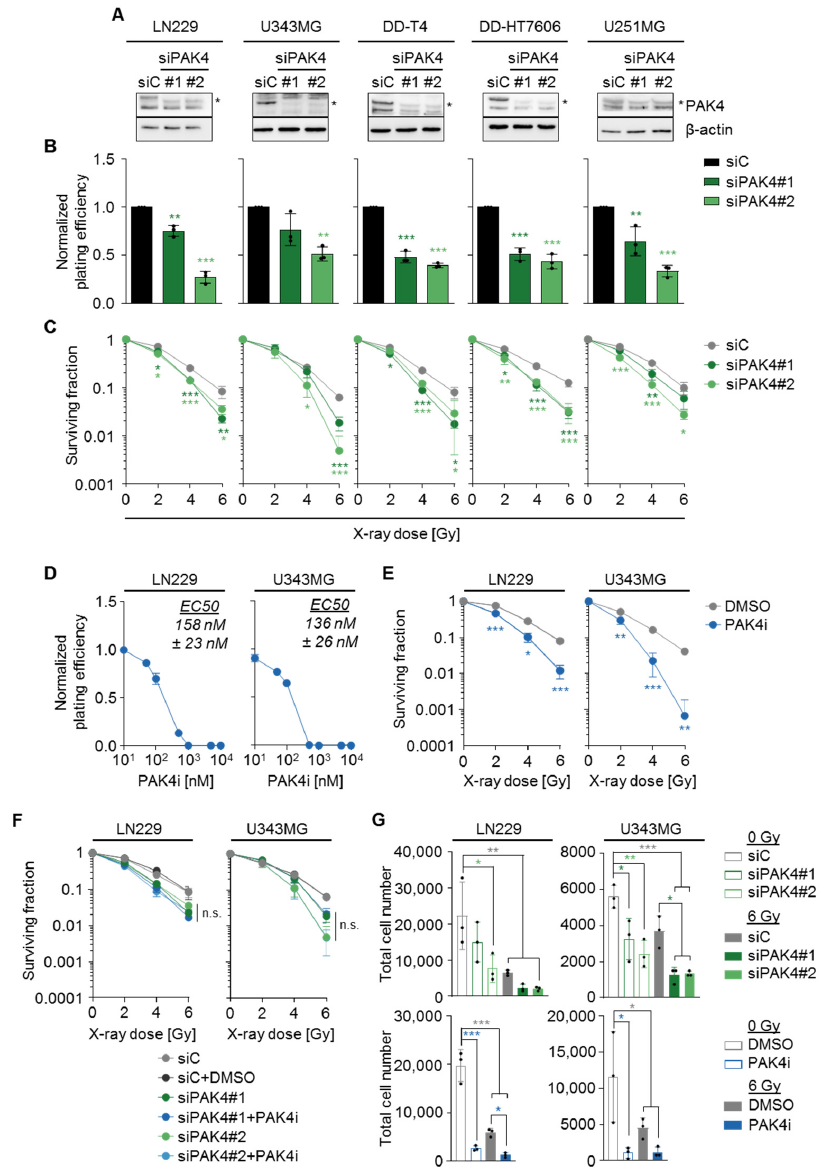
Figure 3. PAK4 targeting radiosensitizes glioblastoma cells. ( A ) Representative Western blot images showing the efficiency of siRNA-mediated knockdown of PAK4 in whole-cell lysates of LN229, U343MG, DD-T4, DD-HT7606, and U251MG cells. β -actin served as loading control. ( B ) Normalized plating efficiency of indicated glioblastoma cells upon siRNA-mediated knockdown of PAK4. ( C ) Surviving fraction of indicated glioblastoma cell lines after siRNA-mediated knockdown of PAK4 combined with X-ray irradiation (0–6 Gy). ( B , C ) Data show means +/ − SD (N = 3 independent experiments, one-way ANOVA, Dunnett’s post-hoc test, * p < 0.05, ** p < 0.01, *** p < 0.001) ( D ) Normalized plating efficiency of LN229 and U343MG cells treated with increasing doses of the PAK4 inhibitor PF-3758309. EC50 values were calculated based on the dose–response curves. ( E ) Surviving fraction of LN229 and U343MG glioblastoma cells after treatment with PAK4i EC50 in combination with X-ray irradiation. Data show means +/ − SD (N = 3 independent experiments, t -test, * p < 0.05, ** p < 0.01, *** p < 0.001) ( F ) Surviving fraction of LN229 and U343MG cells after treatment with siPAK4 and siPAK4 plus PAK4i combined with X-ray irradiation. ( G ) Total cell number indicating proliferation of LN229 and U343MG cells 5 days after siRNA-mediated knockdown of PAK4 (upper panels) and treatment with PAK4i EC50 (lower panels) in combination with X-ray irradiation. ( F , G ) Data show means +/ − SDs (N = 3 independent experiments, one-way ANOVA, Bonferroni’s post-hoc test, * p < 0.05, ** p < 0.01, *** p < 0.001, n.s. not